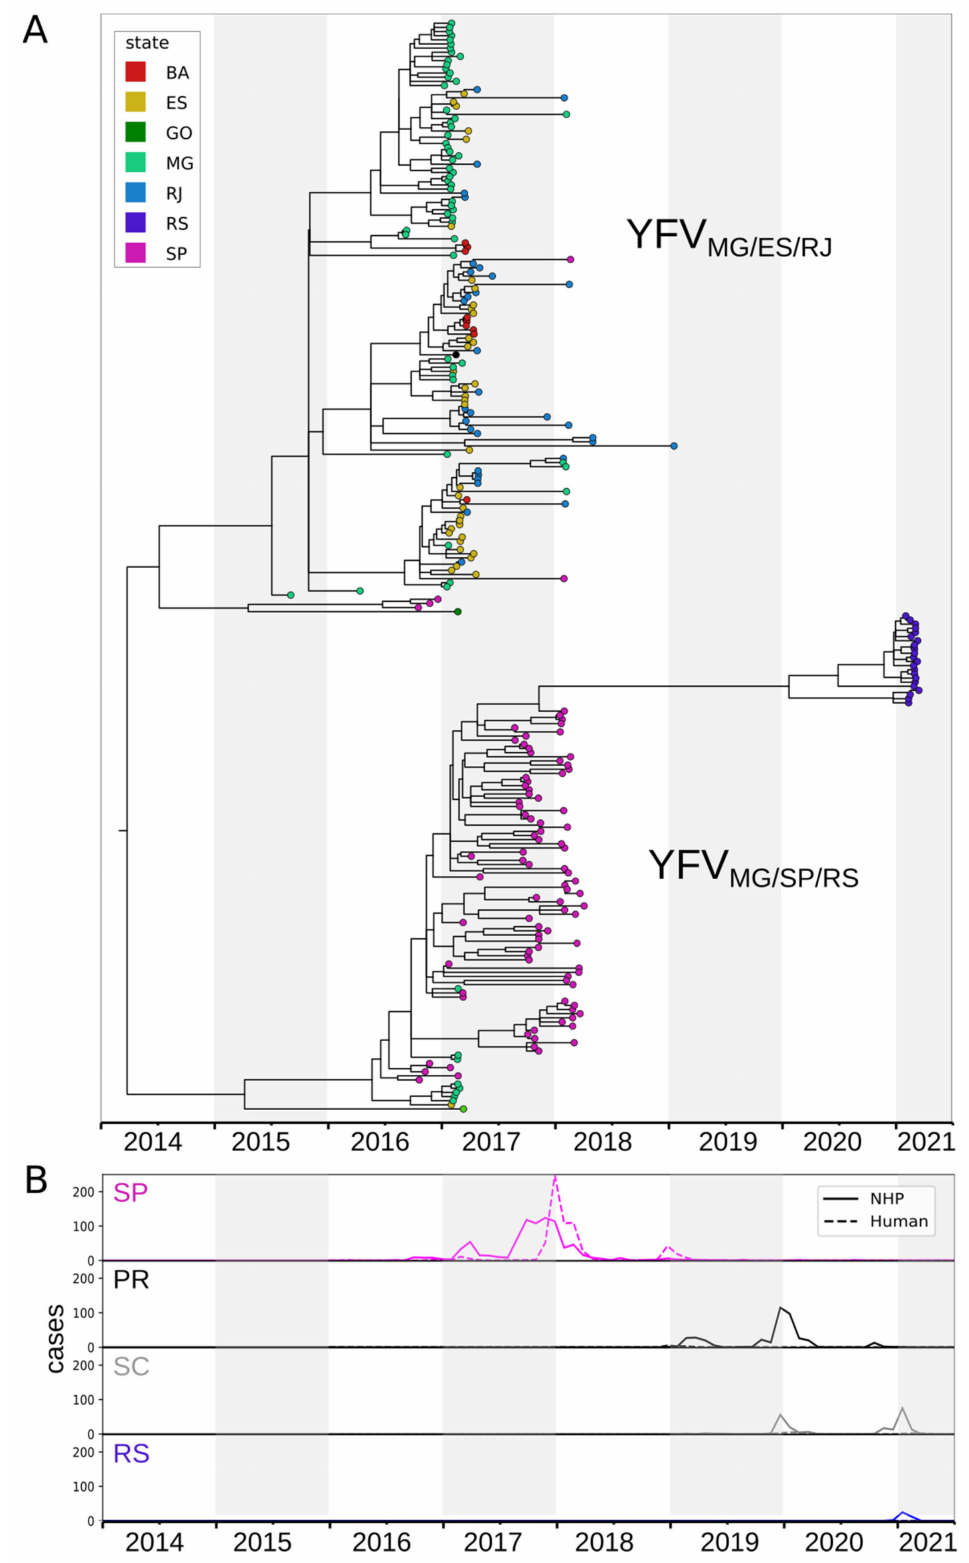
Figure 3. Spatio-temporal YFV spread. ( A ) Time-scaled phylogenetic tree of YFV MG/ES/RJ and YFV MG/SP/RS sub-lineages. ( B ) Epizootics and human cases of YF reported in S ã o Paulo (SP), Paran á (PR), Santa Catarina (SC), and Rio Grande do Sul (RS) by month (Source: Ministry of Health of